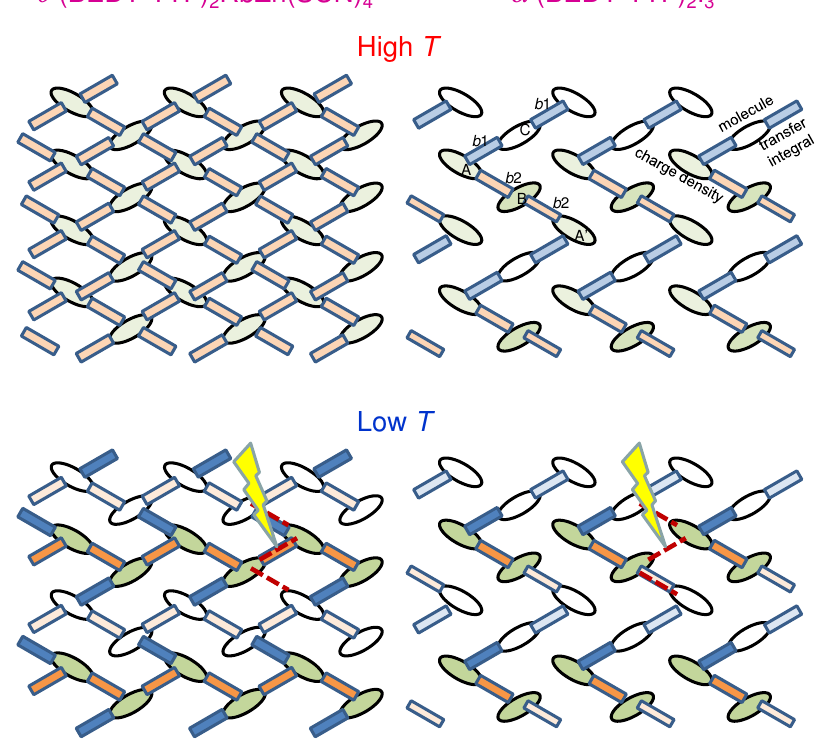
Schematic electronic and lattice structures of θ -(BEDT-TTF) RbZn(SCN) 2 4 (left) and α -(BEDT-TTF) I (right) at high temperatures (upper) and at low temperatures 2 3 (lower). The dashed lines in the lower panels indicate local photoexcitations used in the Hartree–Fock calculations. θ -(BEDT-TTF) α -(BEDT-TTF) RbZn(SCN) I 2 4 2